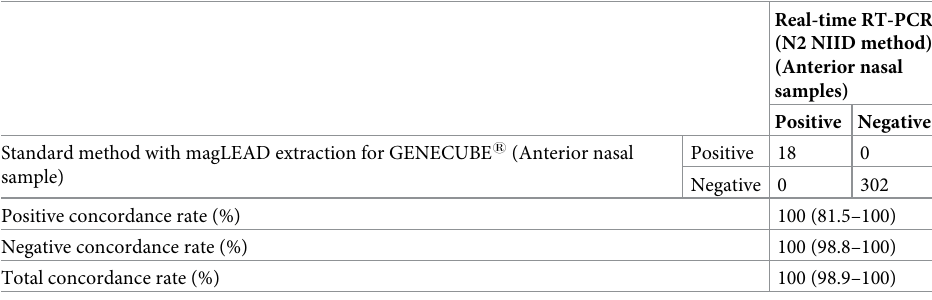
Comparison of the reference RT-PCR and GENECUBE 1 for the detection of SARS-CoV-2 with anterior nasal samples In this study, we prospectively evaluated 359 fresh anterior nasal samples, including 59 samples with positive SARS-CoV-2 results for simultaneously collected nasopharyngeal samples (cycle threshold (Ct) < 20, n = 40; Ct � 20 to < 30, n = 16; Ct � 30, n = 3) (S1 Table). Of the 359 anterior nasal samples, 298 (83.0%) were obtained from asymptomatic patients. The comparison of the reference RT-PCR and GENECUBE 1 (standard protocol) for the detection of SARS-CoV-2 with anterior nasal samples is summarized in Tables 4–6. For ante- rior nasal samples prospectively obtained from suspected COVID-19 patients (Table 4), the total, positive and negative concordance of the 2 assays were 100% (320/320), 100% (18/18) and 100% (302/302), respectively. With the addition of the enriched positive patients, the total, positive and negative concordance of the 2 assays were 99.7% (358/359), 98.1% (51/52) and Table 4. Concordance rate of the GENECUBE 1 HQ SARS-CoV-2 with real-time RT-PCR for anterior nasal sam- ples obtained from suspected COVID-19 patients.